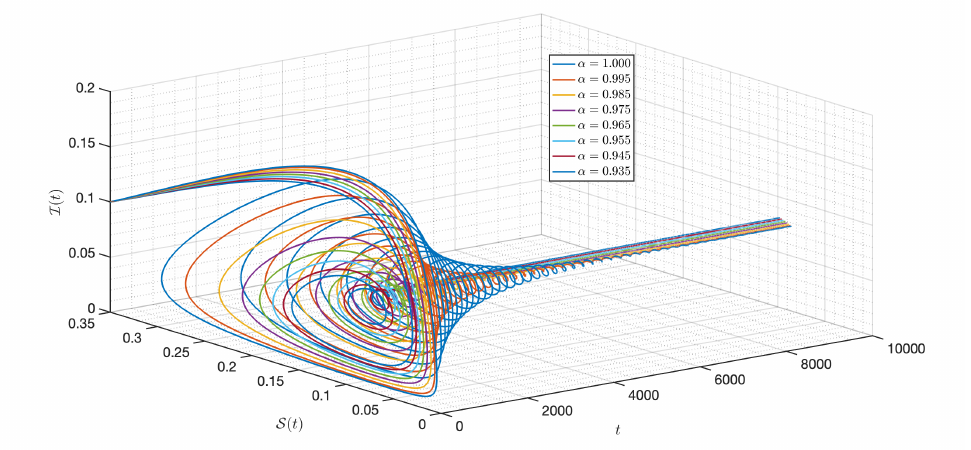
Figure 9. Dynamic of the model (3) for different parameters in Case I